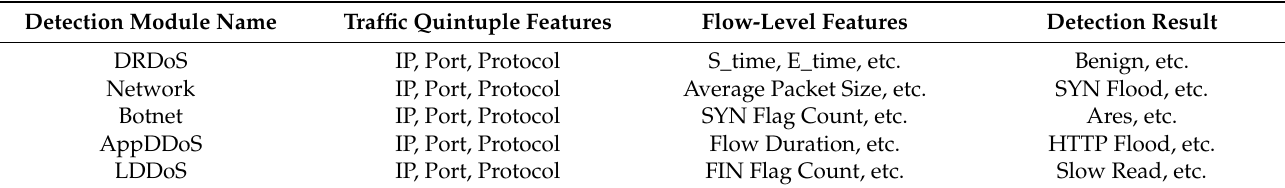
Table 3. Detection result table of each